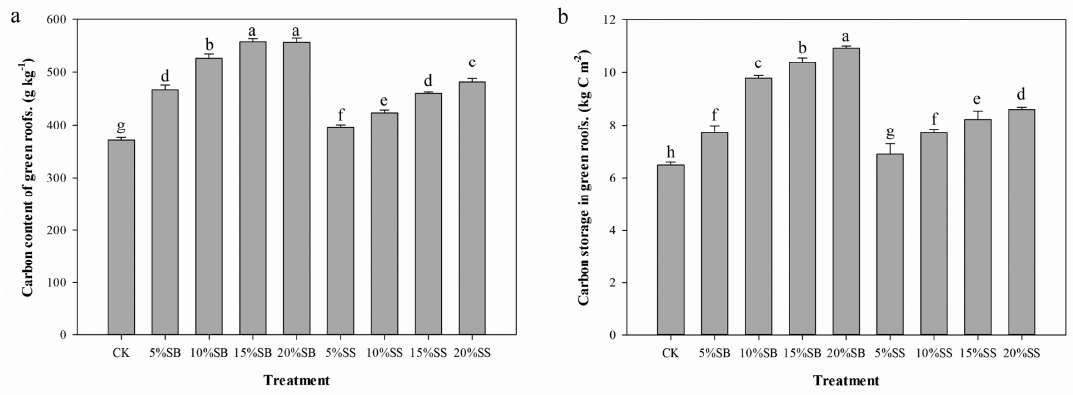
Figure 4. Total carbon content and carbon storage of the green roof. ( a ) Total carbon content (g kg − 1 ) of different green roofs. ( b ) Carbon storages (kg C m − 2 ) of different green roofs.